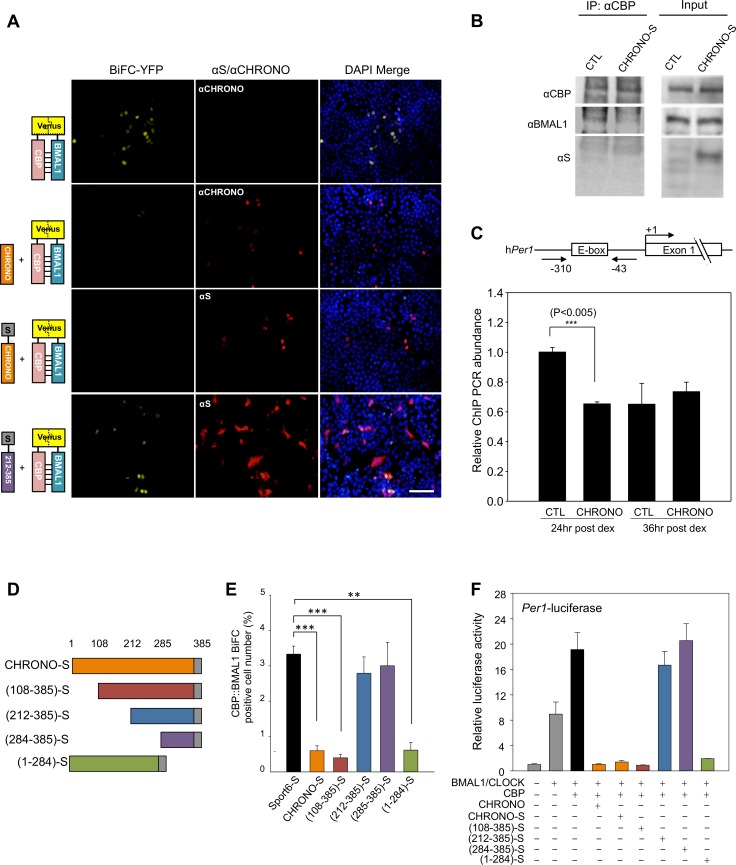
CHRONO interferes with BMAL1–CBP binding.(A) BiFC was used to observe BMAL1–CBP interactions in the nuclei of HEK 293T cells. Co-expression of intact or S-tagged CHRONO reduced the complementation signal. Expression of the 212–385 CHRONO truncation mutant had no discernable effect. (B) IP confirms CHRONO-mediated interference in BMAL1/CBP complex formation. Endogenous protein was immunoprecipitated with anti-CBP antibody followed by immunoblotting as indicated. (C) ChIP qPCR analysis was used to evaluate the effect of CHRONO on the acetylation of histone H3–K9 near the Per1 promoter E-box region. Schematic diagram of the human Per1 promoter and primers used for ChIP assay are shown. Lysates obtained from control U2OS cells and those stably expressing CHRONO were collected 24 and 36 h after dexamethasone synchronization. ChIP DNA samples were quantified by quantitative real-time RT-PCR. Data are mean ± standard error of biological triplicates. (D) Various S-tagged, N-, and C-terminal CHRONO truncation mutants were generated. (E) Percent of cell nuclei demonstrating complementation after overexpression of various CHRONO constructs. (F) Per1:luciferase reporter signal in unsynchronized cells overexpressing BMAL1/CLOCK is enhanced by the transient overexpression of CBP. The effect of the overexpression of CHRONO constructs on reporter activity is shown.